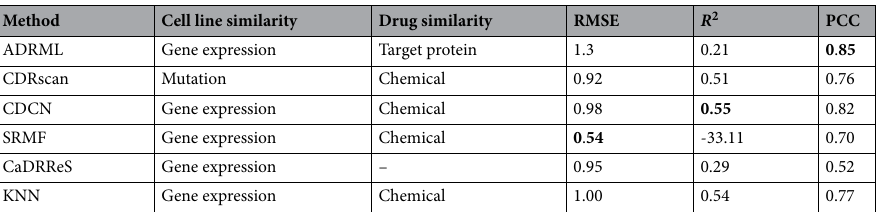
Table 6. Comparison of methods’ performance on the purified GDSC dataset. The methods were evaluated by averaging over 30 repetitions of fivefold cross-validation on cell line-drug pair. The best result of each criterion is shown in